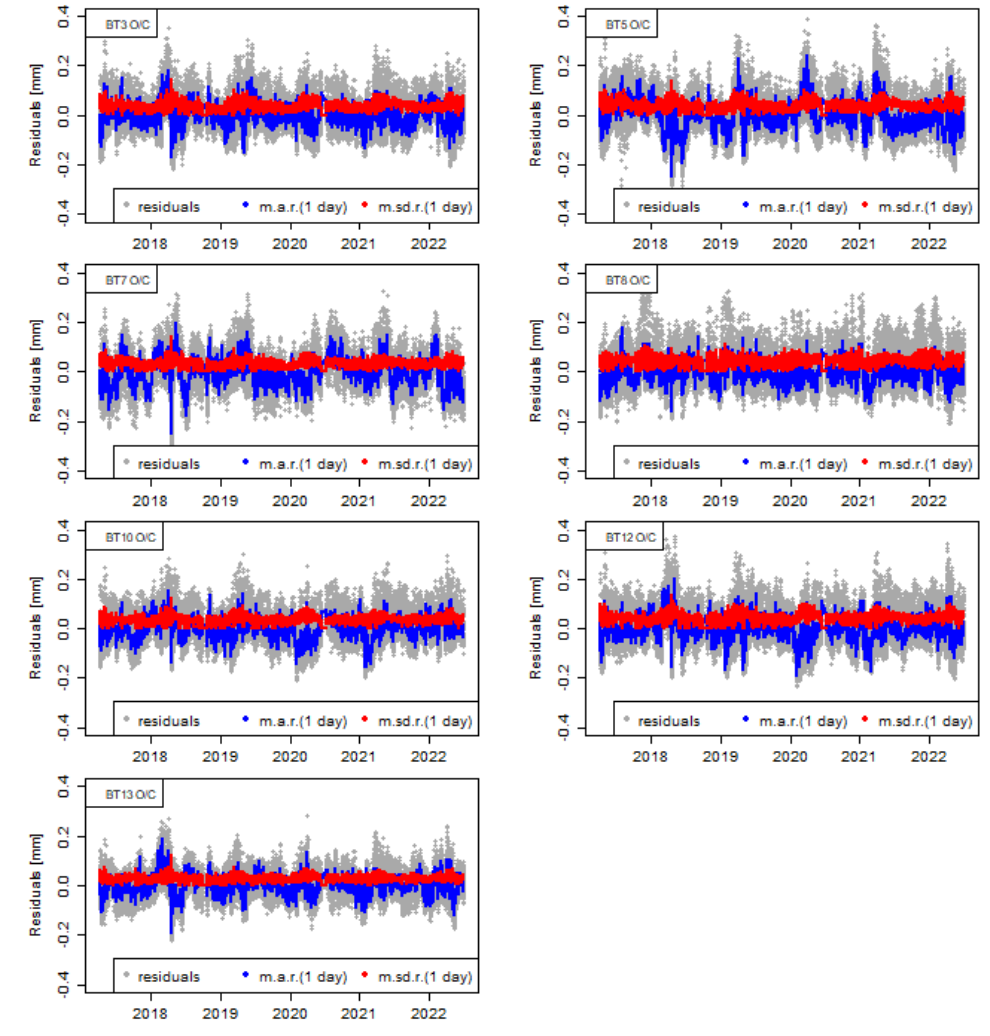
Figure 16. Residuals, m . a . r ., and m . sd . r . over time. The simultaneous analysis of the m . a . r . and m . sd . r . allows us to identify if the predicted values are moving away from the recorded values (i.e., if the residuals are increasing, meaning that the non-explained part of the model is increasing), and if the residuals increase along time, this could suggest a damage evolution. The definition of thresholds based on multiplicative factors associated with the standard deviation of the residuals is also proposed in this analysis. Similar to the single record analysis, thresholds based on multipliers of 3 and 4 for the standard deviation of the residuals are also proposed, although these values can be updated depending on the results, as seen in Figure 17. The priority in this kind of analysis is to identify periods in which the residuals and their evolution are higher; consequently, a deeper analysis of the data can be carried